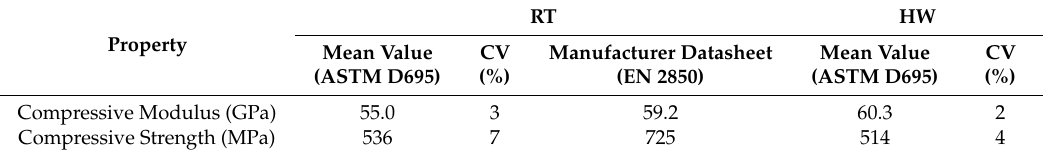
Table 5. Effect of hot-wet storage aging on compressive properties of warp-directional laminates.